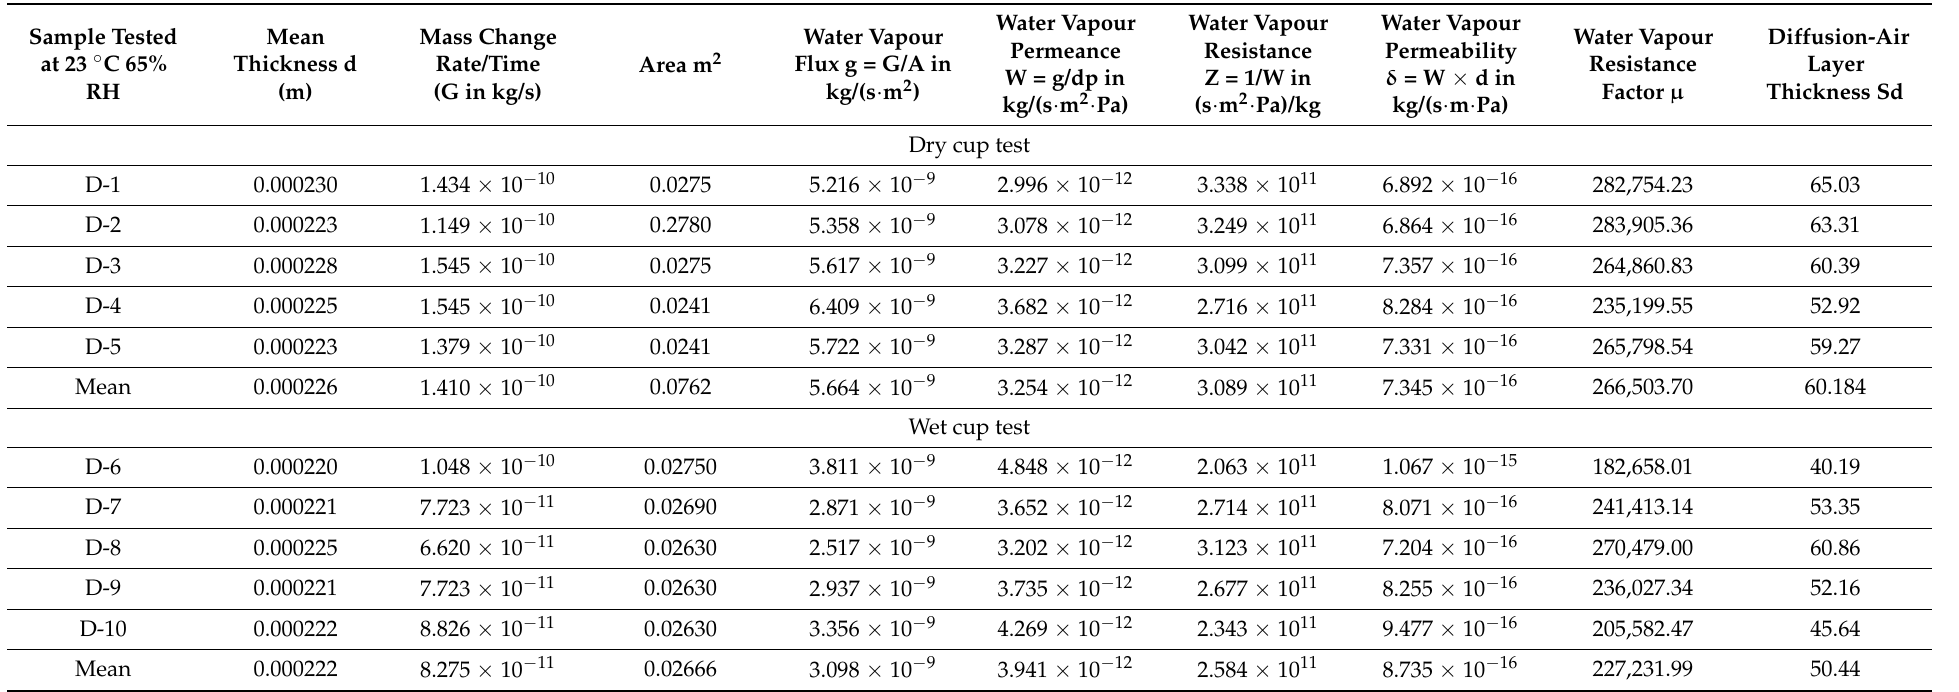
Table A8. Water vapour resistivity properties for sample D at 23 ◦ C 65%